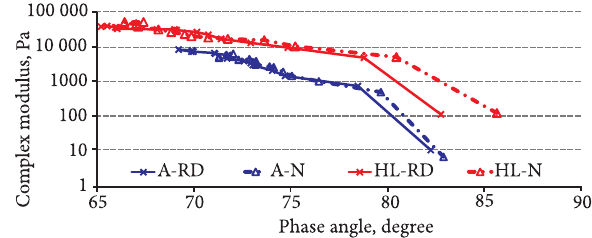
Fig. 3. The dynamic viscosity versus temperature of the bitumen extracted from SMA pavement at temperature from 60 °C to 135 °C